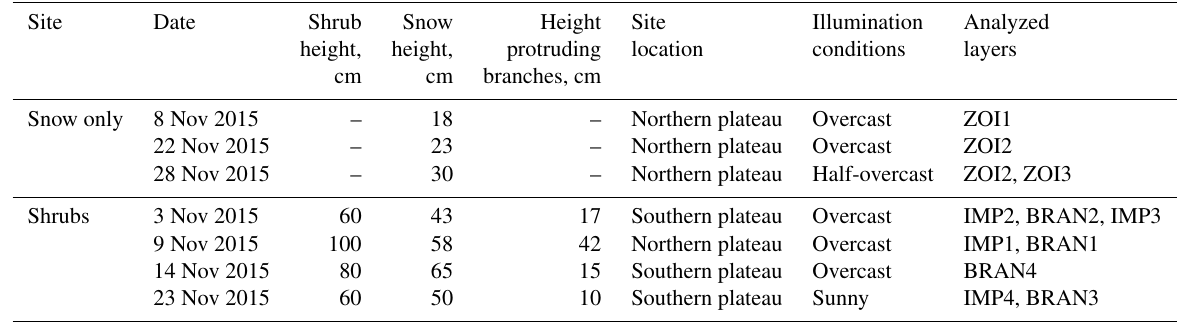
Table 1. Snow height and shrub height in Umiujaq for the three shrub-free snowpacks and the four snowpacks with shrubs. Site Date Shrub Snow Height Site Illumination Analyzed height, height, protruding location conditions layers cm cm branches, cm Snow only 8 Nov 2015 – 18 – Northern plateau Overcast ZOI1 22 Nov 2015 – 23 – Northern plateau Overcast ZOI2 28 Nov 2015 – 30 – Northern plateau Half-overcast ZOI2, ZOI3 Shrubs 3 Nov 2015 60 43 17 Southern plateau Overcast IMP2, BRAN2, IMP3 9 Nov 2015 100 58 42 Northern plateau Overcast IMP1, BRAN1 14 Nov 2015 80 65 15 Southern plateau Overcast BRAN4 23 Nov 2015 60 50 10 Southern plateau Sunny IMP4,